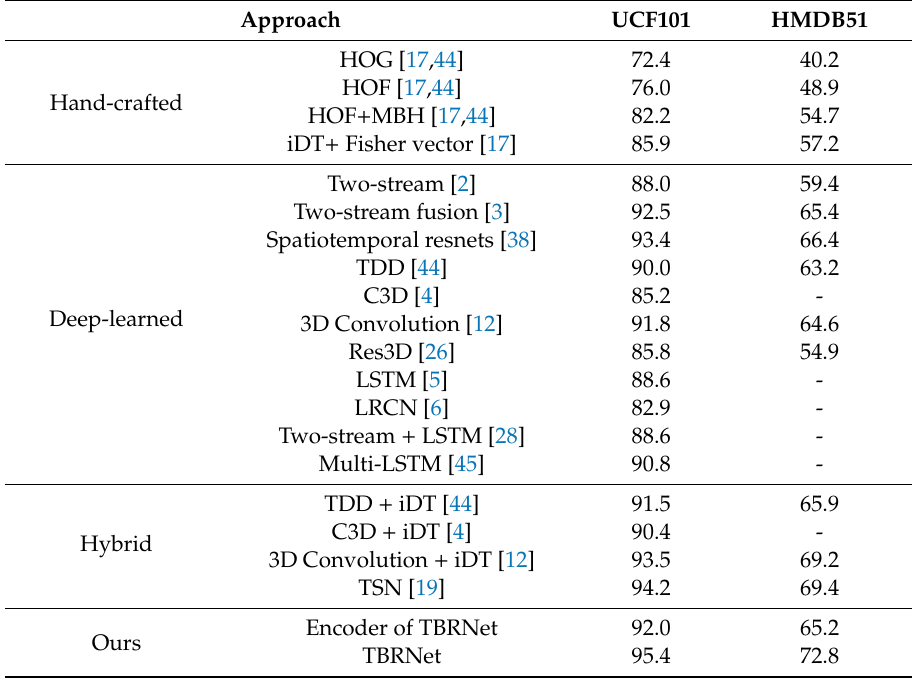
Table 5. Compared performances of our proposed TBRNet with state-of-the-art approaches on UCF101 and